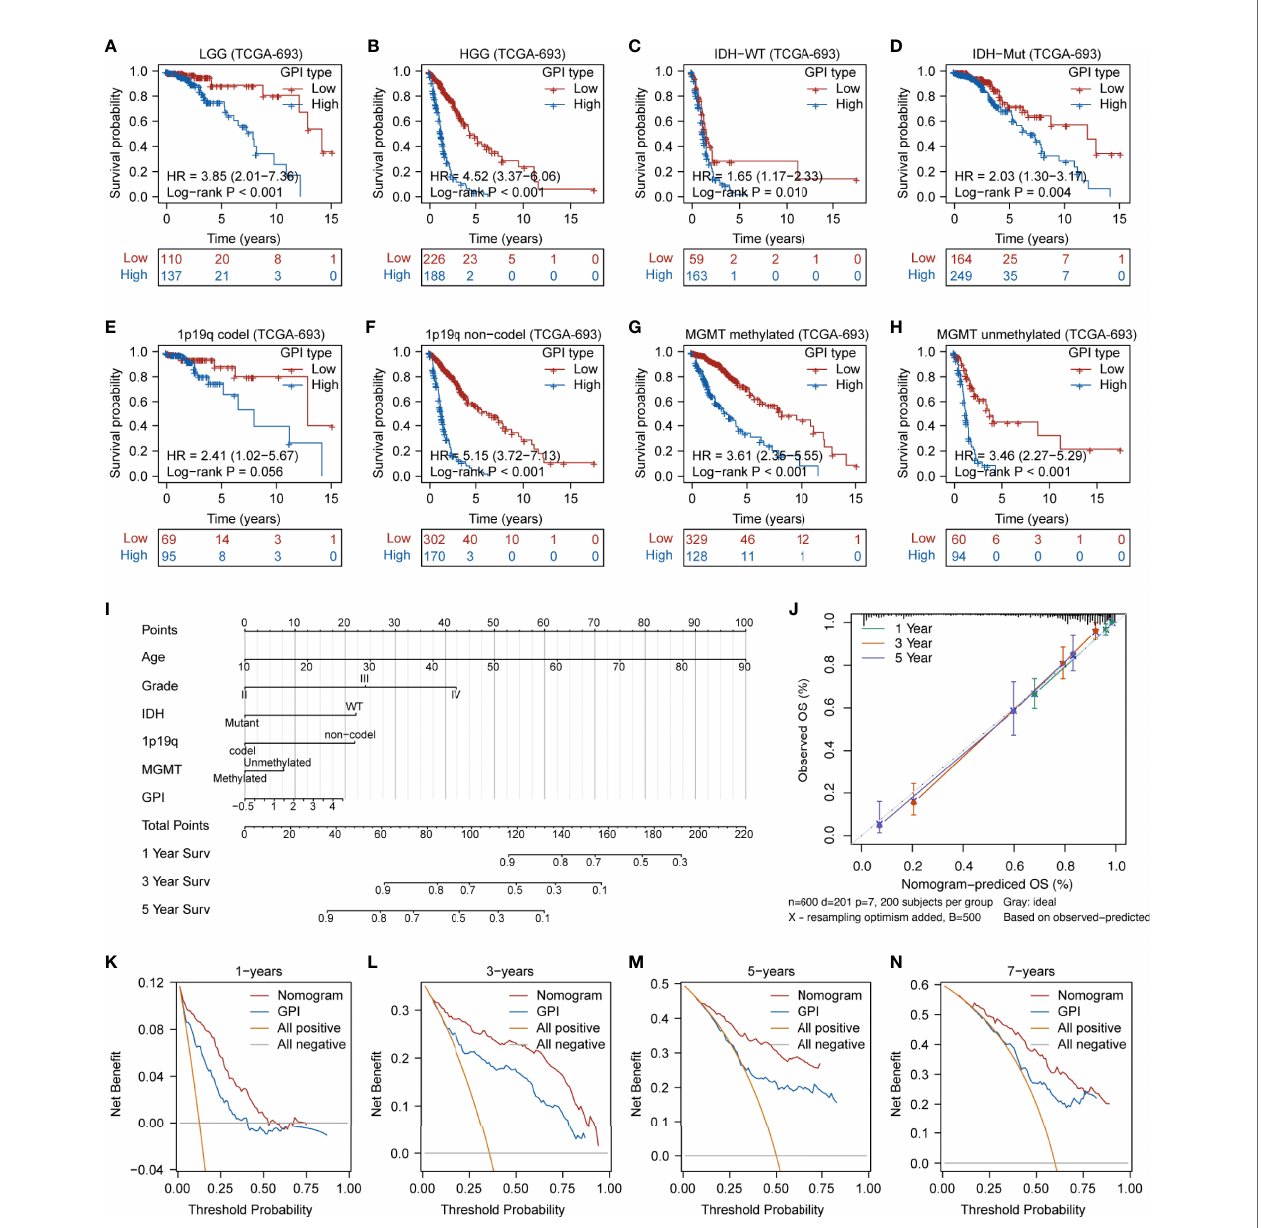
FIGURE 6 | Prediction accuracy of GPI in glioma samples with different clinical characteristics and prognostic nomogram construction. Survival analysis between GPI-high and GPI-low in LGG (A) , HGG (B) , IDH -WT (C) , IDH -Mut (D) , 1p19q-codel (E) , 1p19q non-codel (F) , MGMT -promoter methylated (G) , and MGMT - promoter unmethylated (H) groups in glioma. (I) Nomogram was developed with the age, grade, IDH mutational status, 1p19q codeletion status, MGMT -promoter methylation status, and GPI. (J) Calibration plot for nomogram. (K – N) Decision curve analysis (DCA) of 1-, 3-, 5-, and 7-year overall survival for GPI and